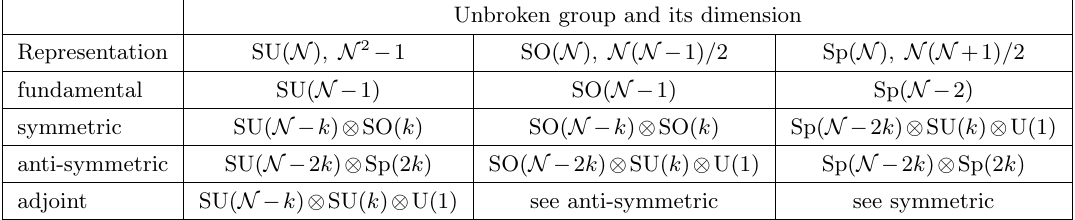
Table 1 . Breaking patterns with one irreducible scalar representation of small size, such that the gauge group con(cid:12)nes for any N . The symmetric of SO( N ) is trace-less, with a similar condition on the anti-symmetric of Sp( N ). The values of k at the absolute minima of renormalizable potentials [2] and of Coleman-Weinberg potentials are either minimal ( k = 1) or maximal ( k = N or N (cid:0) 1). We recall that SU(2) = SO(3) = Sp(2), SO(5) = Sp(4), SU(4) = SO(6), SO(4) = SU(2) 2